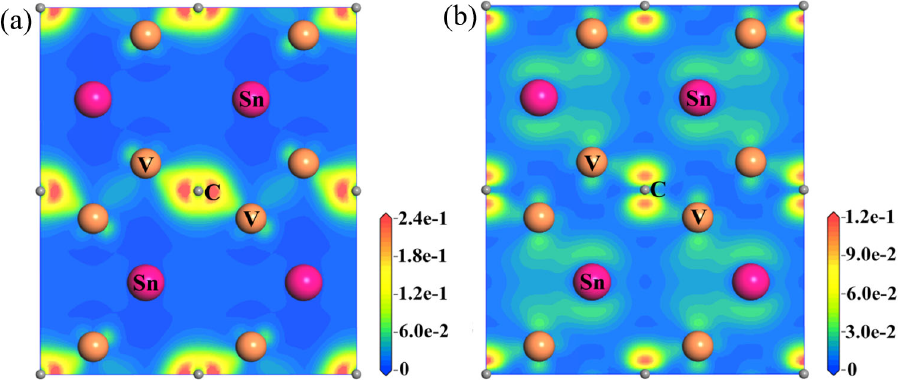
Fig. 8 Electron density maps on (1120) plane of V 2 SnC from (a) –6 to –3 eV and (b) –3 to –1 eV below the Fermi level, and the unit is electron/Å 3